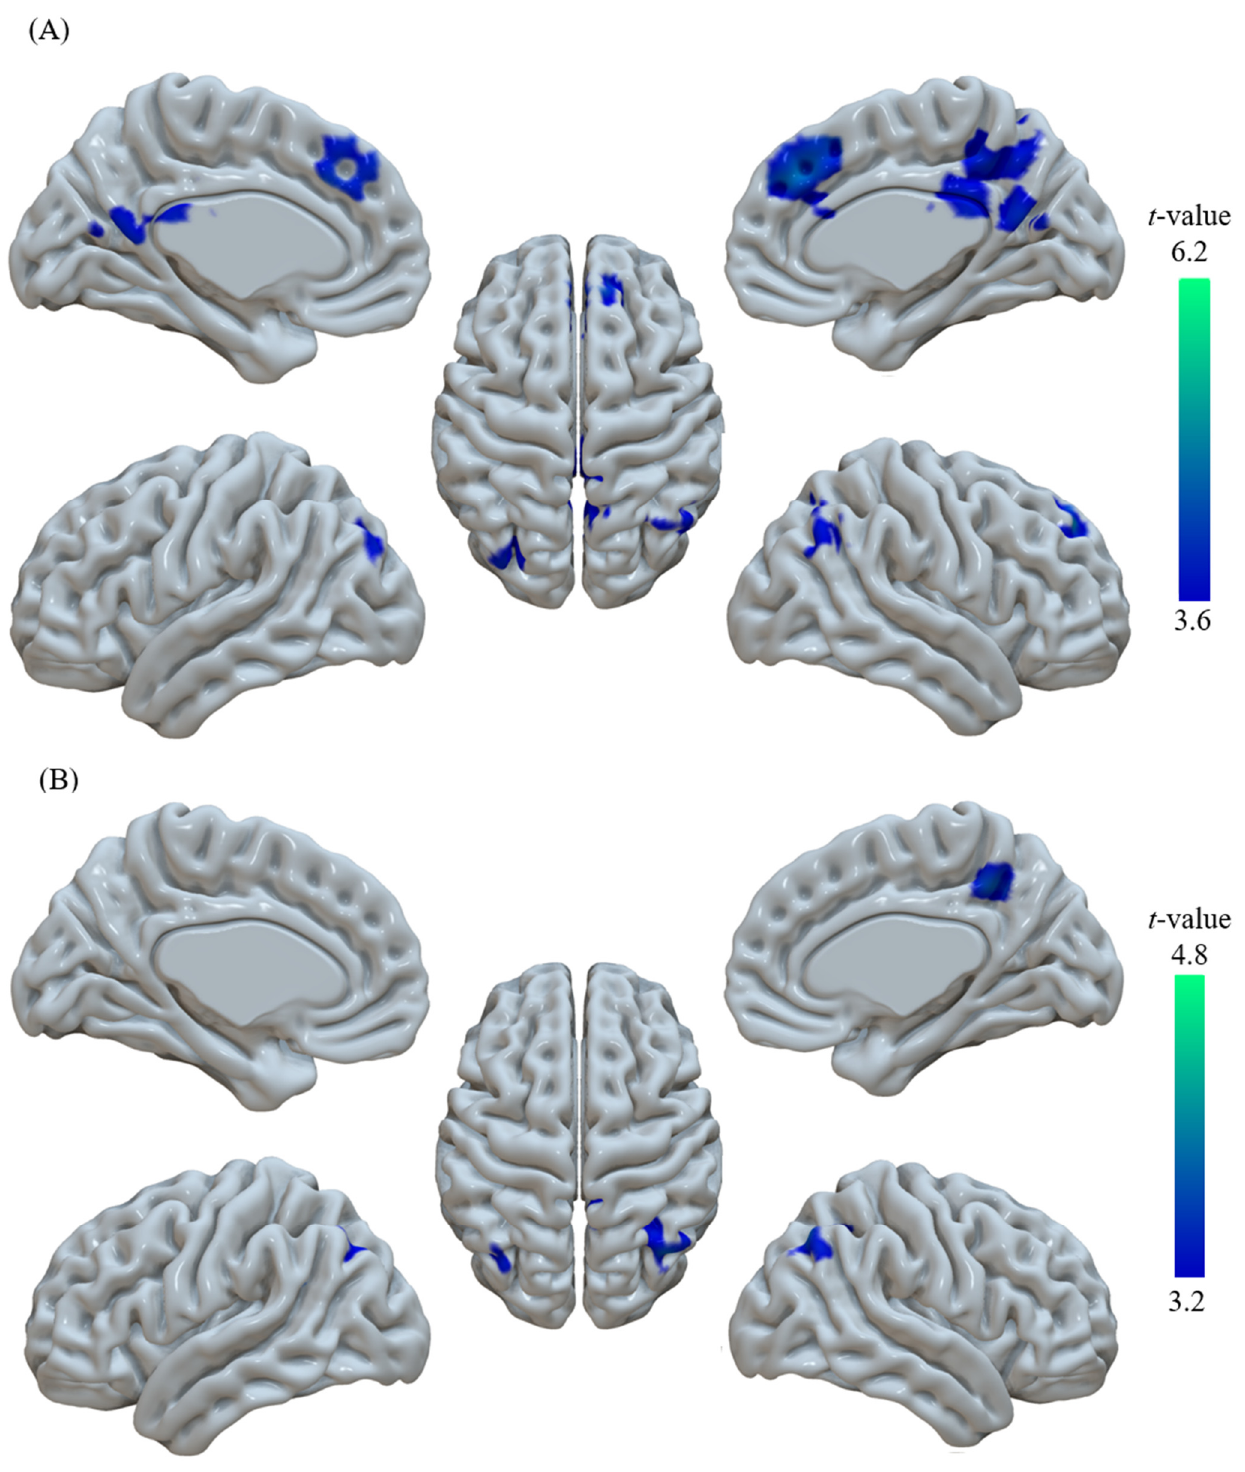
Figure 1. Altered brain regions in the VaMCI group compared with HCs. ( A ) ALFF decrease in the bilateral PCu, R.AG, and R.medFG in the VaMCI group. ( B ) DC decrease in the R.PCu and bilateral AG in the VaMCI group. Color bars indicate t -values. PCu, precuneus; AG, angular gyrus; medFG, medial frontal gyrus; L., left; R., right.